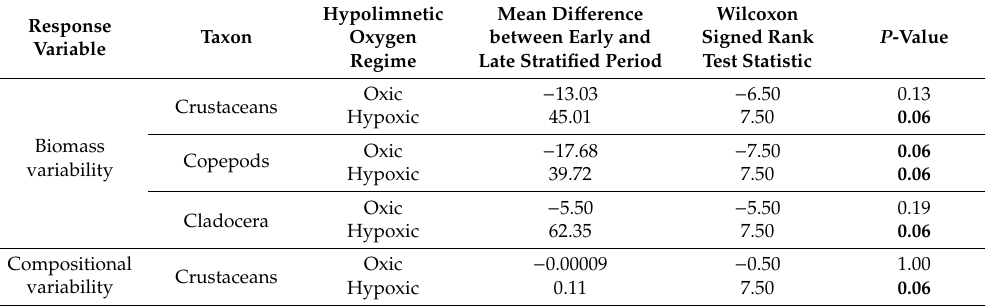
Table 5. Wilcoxon signed rank test statistics of the di ff erence in crustacean zooplankton, cladoceran and copepod biomass variability and the compositional variability of crustacean zooplankton biomass between the early (when all reservoirs were oxic) and late stratified periods across years in oxic and hypoxic reservoirs. Only the compositional variability of total crustacean zooplankton (not individual copepod or cladoceran group taxa) was calculated because there were only two copepod taxa present in the reservoirs. A positive mean di ff erence indicates that the value increased from the early to late stratified period. Bold P -values highlight statistically significant ( P < 0.10) two-tailed P